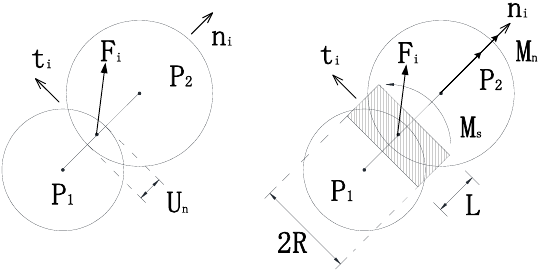
prevent splinters from the impact, and the guide is used to prevent any secondary break- age caused by a rebound after the impact of the falling hammer. Figure 4. Schematic of the drop weight test machine. A single piece of gold ore with a size in the range of 45–37.5 mm across was selected as the test object, and ten repetitive tests per impact energy value were carried out. Under the same impact energy, the fragments of 10 ore samples were collected together and then screened, graded, and weighed to obtain the mass percentage of each size. The specific test parameters are shown in Table 1. Table 1. Drop weight test parameters. Ore Size (mm)